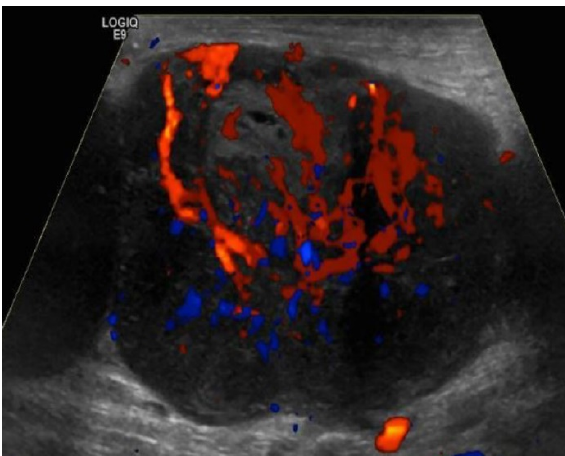
Figure 10. Doppler ultrasound of a right inguinal metastatic lymph node in a 67-year-old male with history of right ankle melanoma shows an enlarged hypoechoic lymph node with mixed (hilar and peripheral) vascularity.